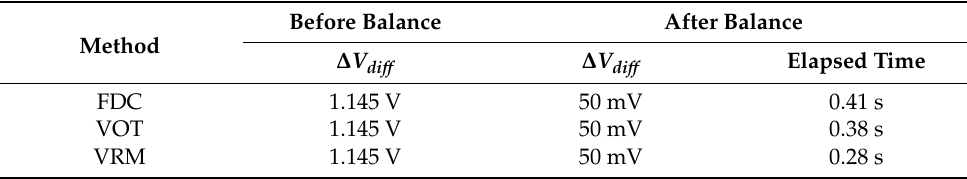
Figure 7. Simulation results of three control strategies: ( a ) FDC method; ( b ) VOT method; and ( c ) VRM method. Table 3. Comparison of equilibrium time by three control